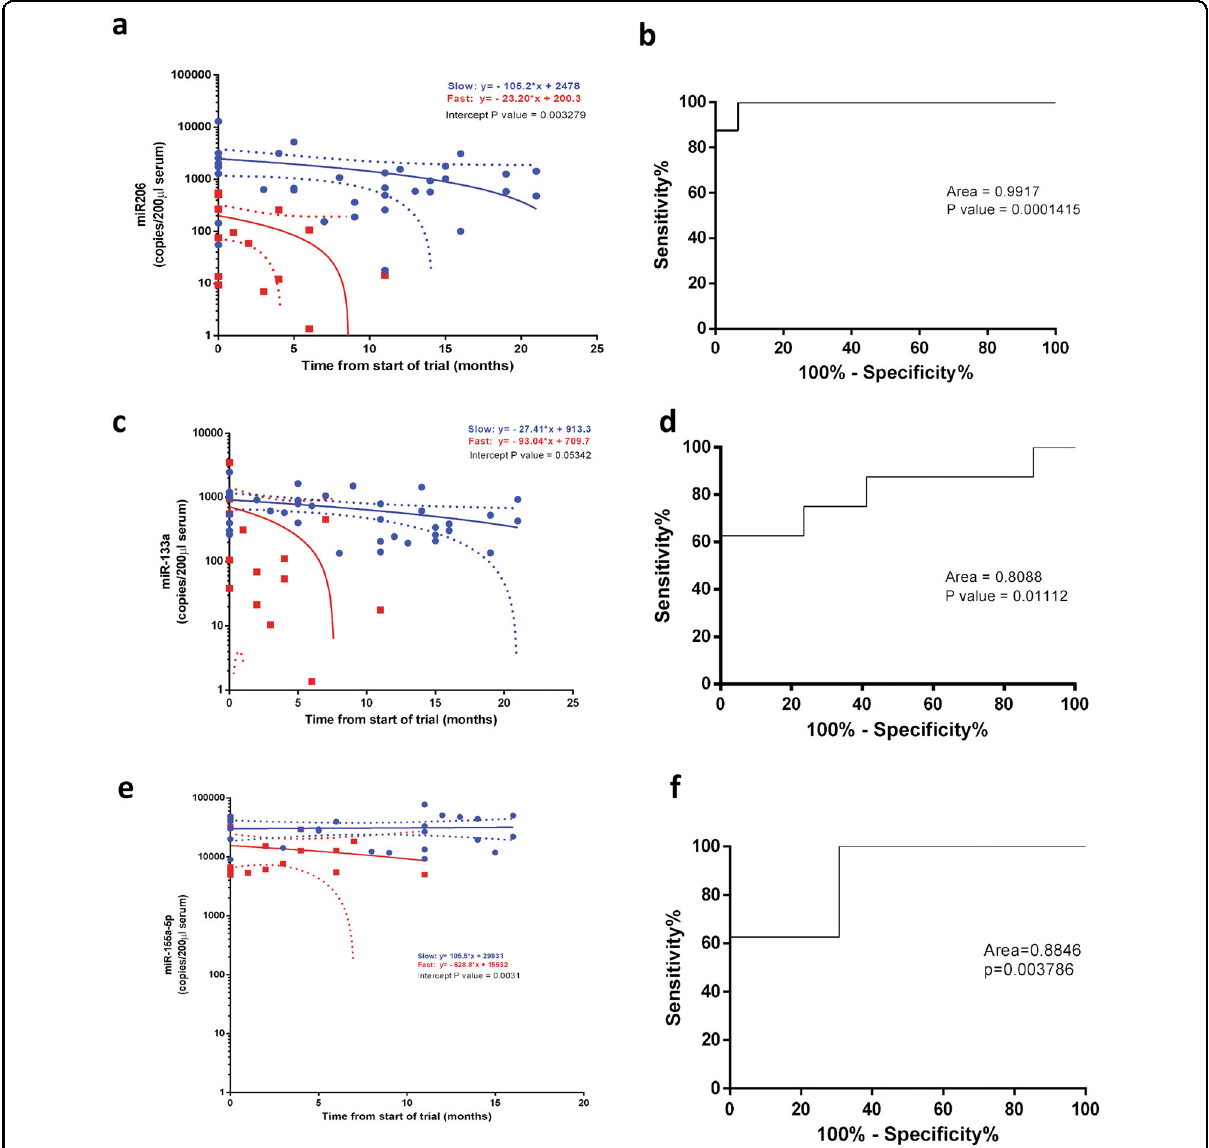
Fig. 4 MiRNA expression levels in slow and fast disease progressing patients. Linear regression analysis of a miR-206, c miR-133a, e miR-151a-5p copies number in fast (red line) and slow (blue line) progressing patients. Roc curve analysis of b miR-206 d miR-133a, f miR-151a-5p copies number in fast and slow progressing patients at time of enrollment. N = 11 (slow), N = 6